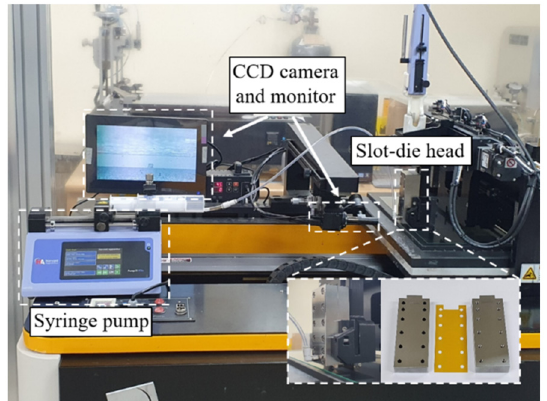
Figure 3. Image of a table slot-die coater and slot-die head used for